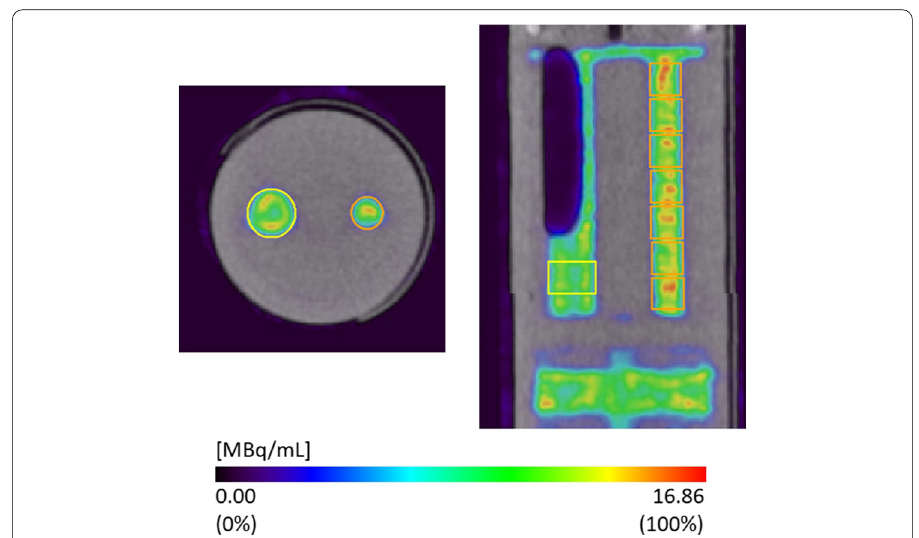
Fig. 1 Overlays of SPECT and CT transverse (left) and longitudinal (right) section images of the physical phantom, filled with a [ 131 I]-NaI solution (10.4 MBq mL − 1 ). VOIs used for analysis are shown as an overlay in yellow (6 mm rod) and orange (4 mm rod) colours. A large air bubble is present inside the 6-mm-diameter rod, which limited the number of VOIs in that rod that could be used for